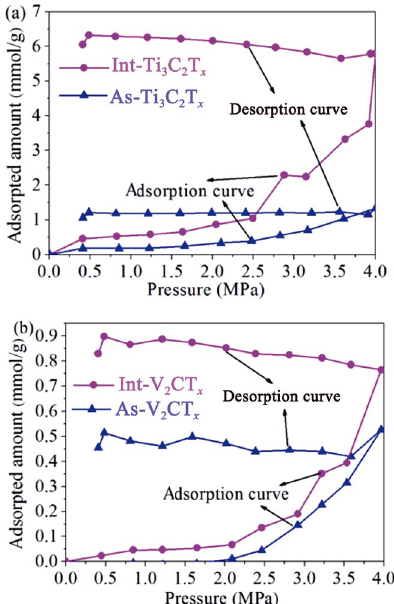
Fig. 6 CO 2 adsorption and desorption curves of MXenes at 298 K under 0–4 MPa: (a) as-Ti 3 C 2 T x and int-Ti 3 C 2 T x , (b) as-V 2 CT x and int-V 2 CT x